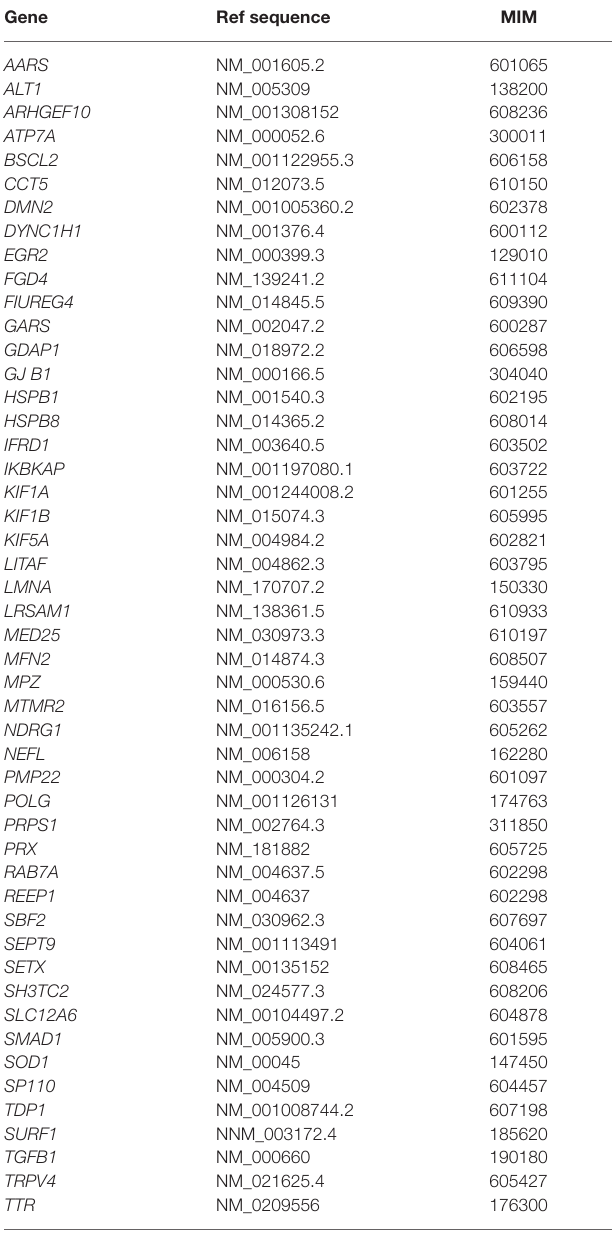
TABLE 1 | Target genes included in NGS